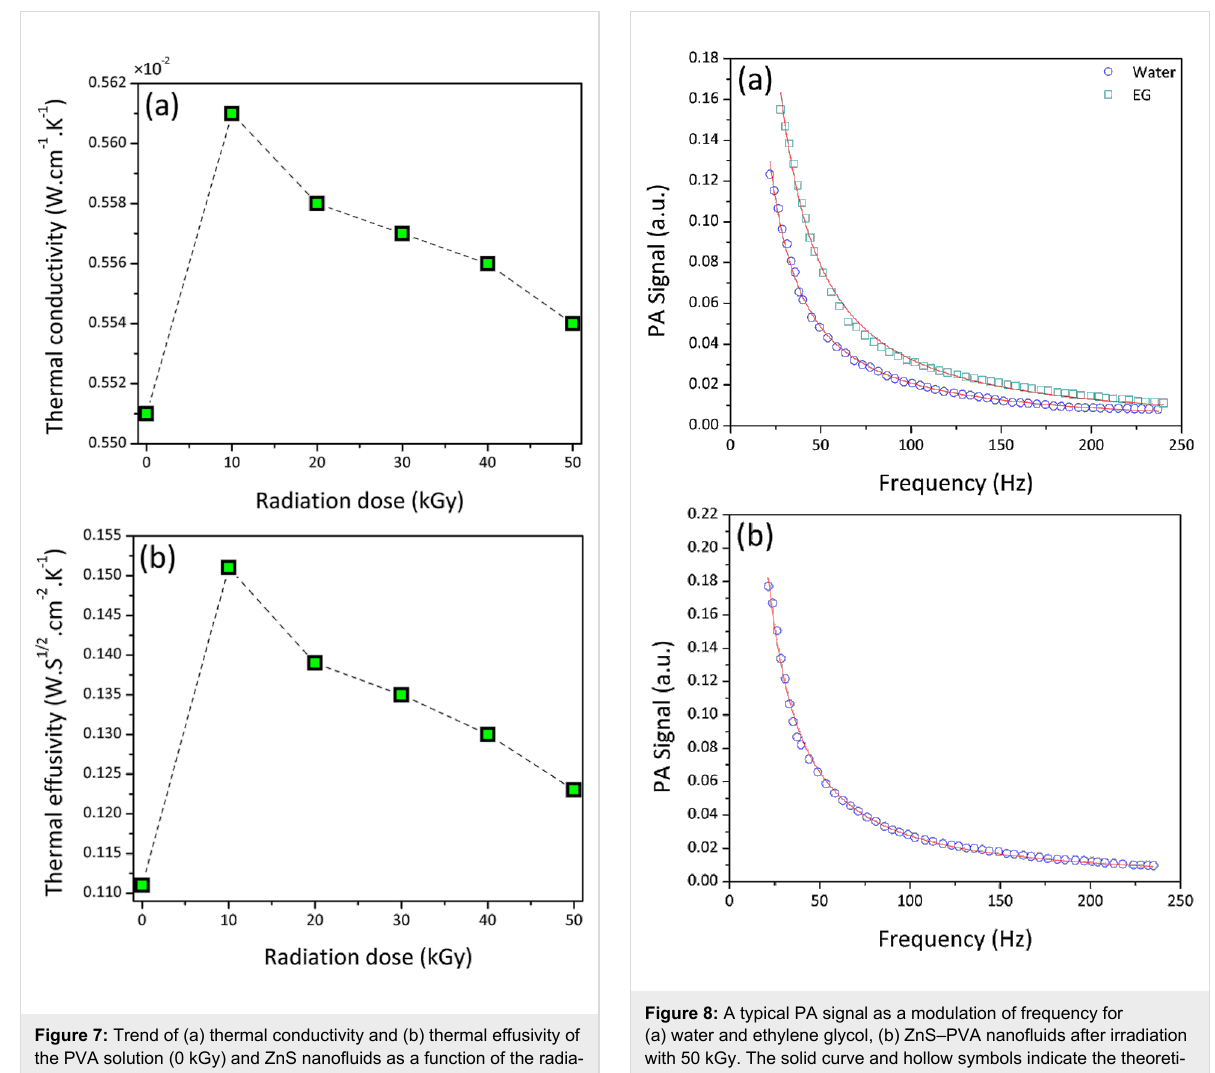
C p , α increases with the irradiation dose, because it is inversely proportional to C p